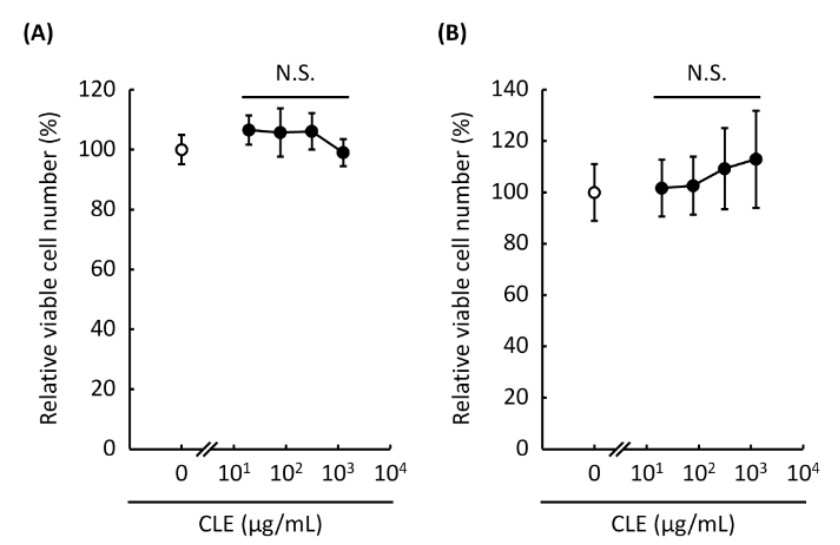
Figure 1. Effect of an aqueous extract from leaves of Citrus unshiu (CLE) on cell viability of RAW 264.7 cells and mouse peritoneal macrophages. RAW 264.7 cells and mouse peritoneal macrophages were treated with various concentrations of CLE for 24 h, followed by LPS stimulation for 6 h. Relative viable cell number was then measured using a WST-8 reagent. An open circle indicates the control cells treated with water instead of CLE. Data are represented as mean ± SEM of three independent experiments. N.S. indicates no statistical significance against control by Dunnett’s test. RAW 264.7 cells ( A ), peritoneal macrophages ( B ).